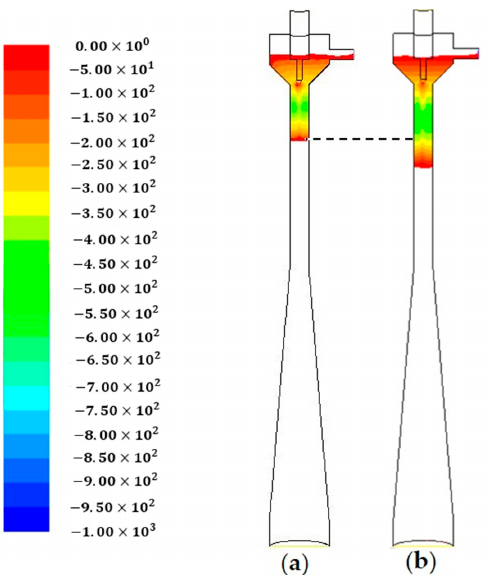
Figure 10. The effects of liquid flow rate on negative pressure, ( a ) flow rate: 2.49 × 10 − 4 m 3 /s, ( b ) flow rate: 2.64 × 10 − 4 m 3 /s.